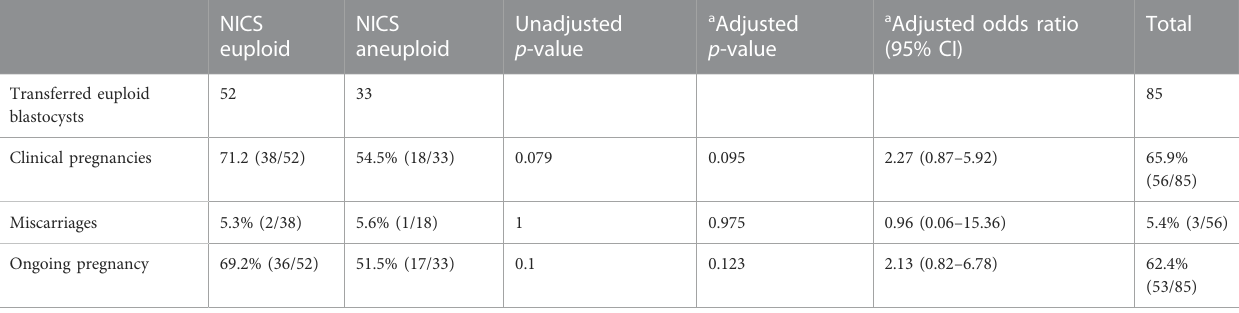
TABLE 4 Comparison of clinical outcomes between the euploid and aneuploid non-invasive chromosomal screening groups in trophocyte euploid embryo